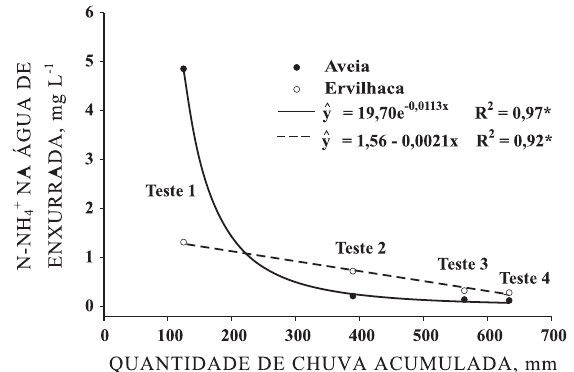
Figura 1. Relação entre o teor de N-NH 4+ na água de enxurrada e a quantidade de chuva acumulada (natural e simulada), durante o ciclo das culturas de aveia e ervilhaca (média das formas de semeadura e das